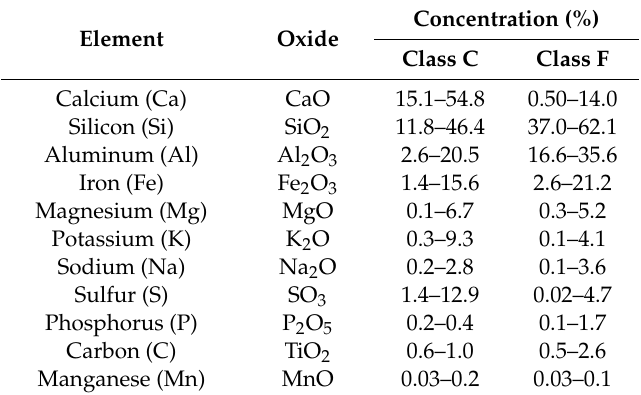
Table 1. Percent range of element oxides present in “Class C” and “Class F” fly ash .